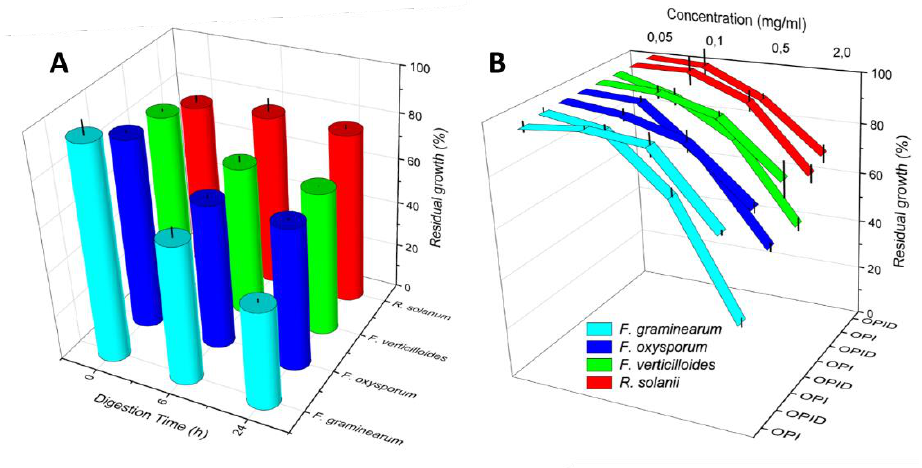
Figure 7. Residual growth of Fusarium spp. and R. solani following OPI and OPID incorporation in the medium. Panel ( A ) Time dependence of inhibition is tested with OPID samples digested for 6 h and 24 h. Panel ( B ): Dose response of inhibition tested with increasing amounts of 24 h OPID. Error bar represents standard deviation.